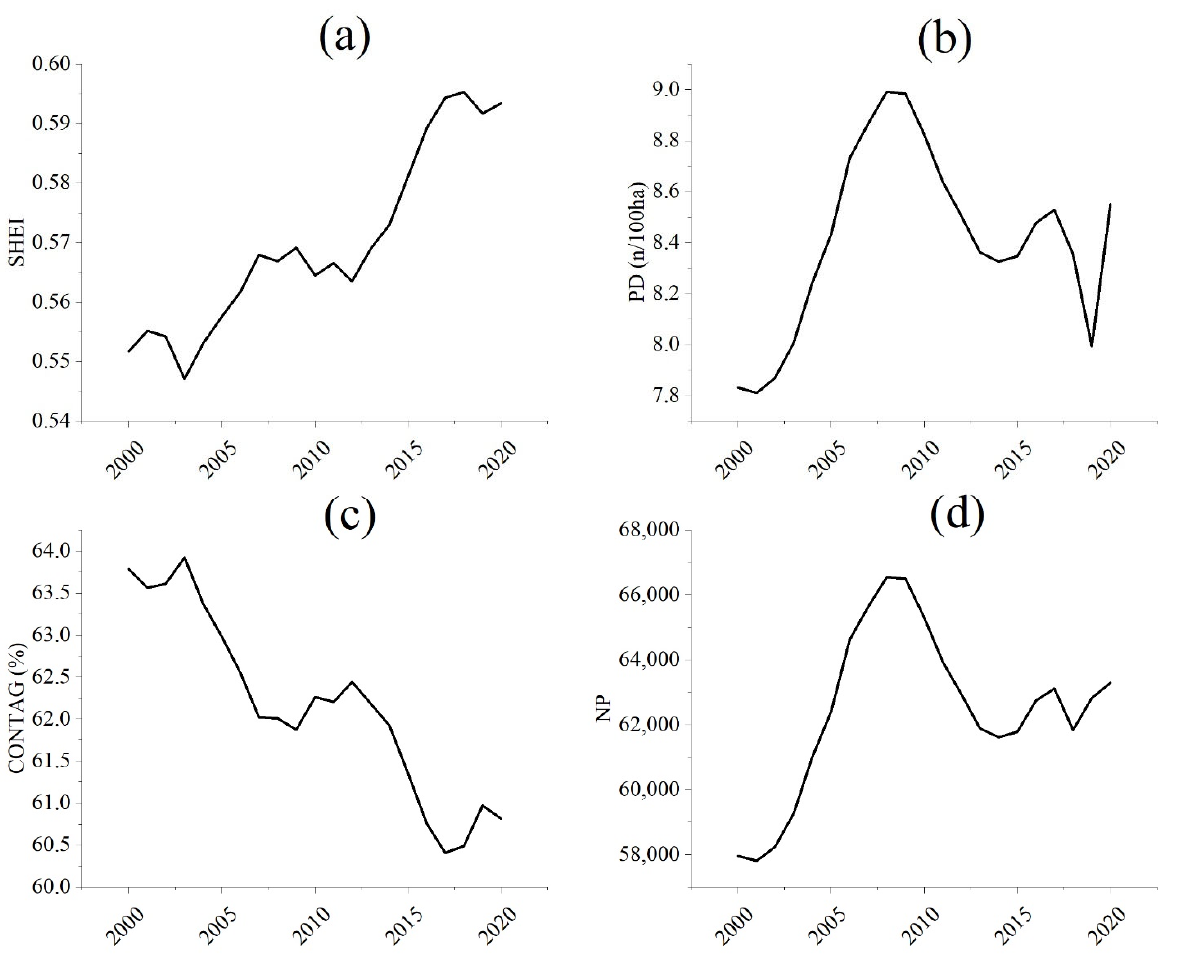
Figure 9. Landscape index change of land use in Nanchang, 2000–2020. ( a ) the Shannon’s Evenness Index (SHEI) of Nanchang from 2000 to 2020; ( b ) the Patch Density (PD) index of Nanchang from 2000 to 2020; ( c ) the Contagion Index (CONTAG) of Nanchang from 2000 to 2020; ( d ) the number of patches (NP) of Nanchang from 2000 to 2020.